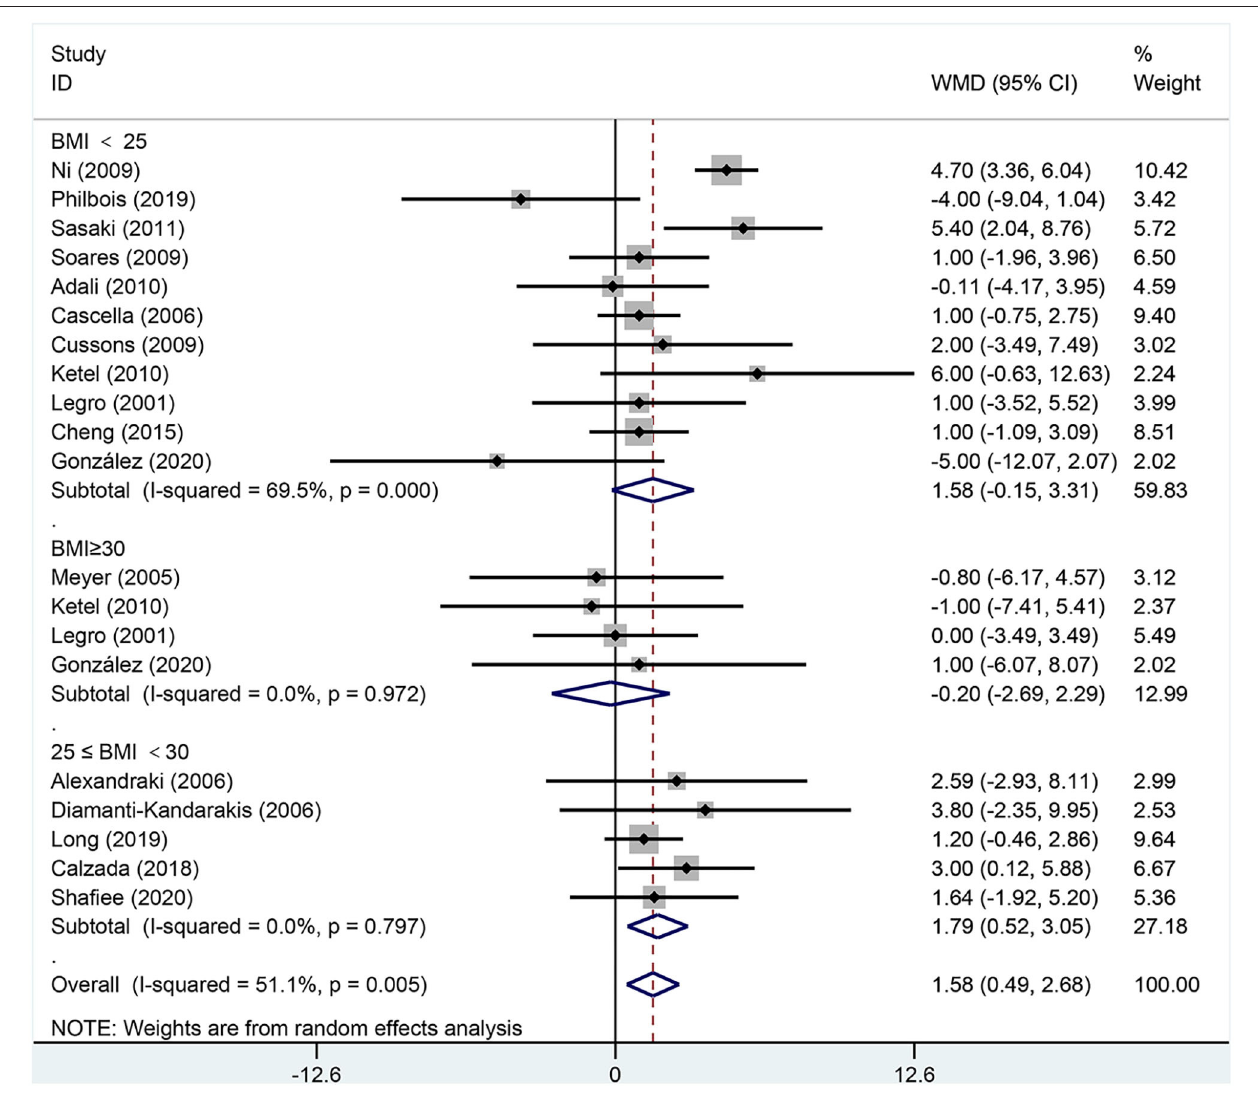
FIGURE 7 | Forest plot for comparison of diastolic blood pressure in polycystic ovary syndrome vs. control subjects. Studies are classified by different body mass index (BMI) categories (BMI < 25 kg/m 2 , BMI ≥ 30 kg/m 2 , and BMI 25–30 kg/m 2